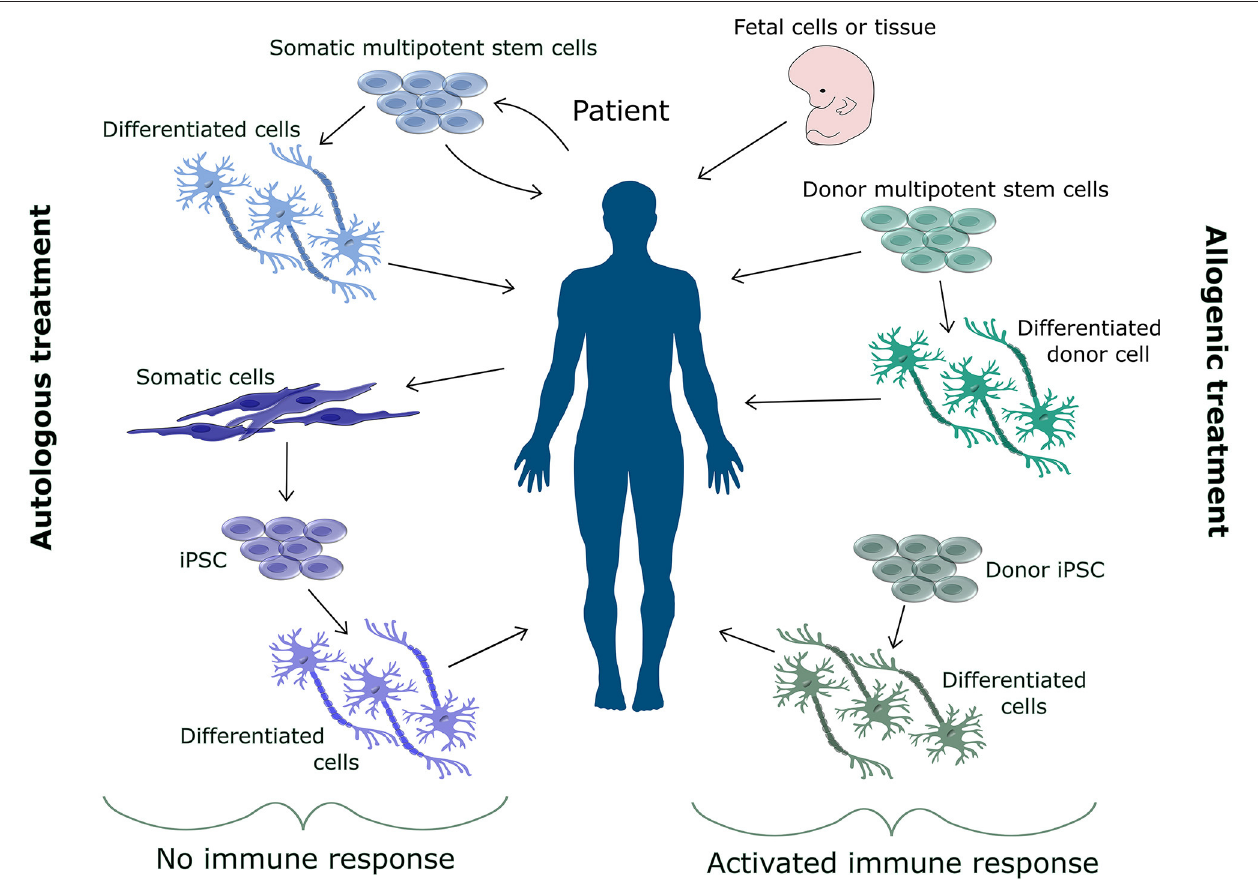
FIGURE 1 | Overview of sources for cell replacement therapy. The source for cell replacement therapy can be either autologous or allogenic. Allogenic cells are associated with an immune response and increase risk of rejection. Therefore, donor cells need to be matched to the patient’s immune system. Various allogenic sources such as fetal cells, somatic stem cells, differentiated cells or derivatives from hiPSC can be used for cell replacement therapy. Autologous cells do not cause an immune response. Autologous cells are extracted from the patient either as somatic stem cells or somatic cells for reprogramming. These cells can be injected back into the patient as multipotent stem cells or as differentiated